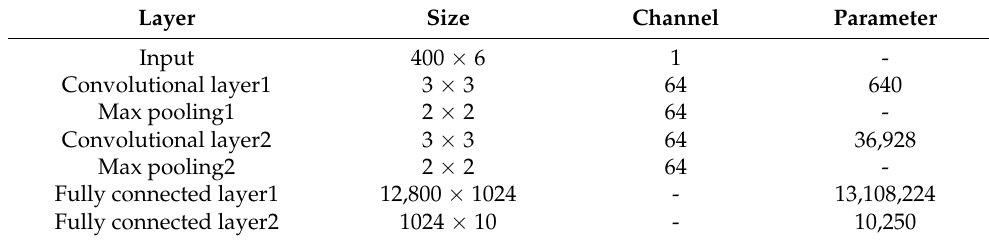
Table 2. The structure of the